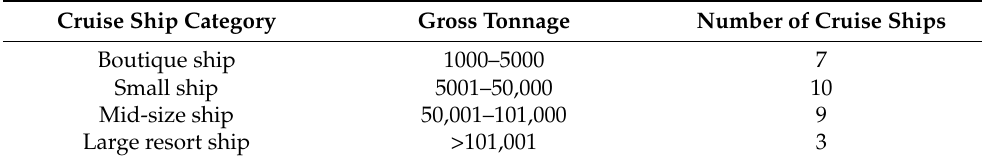
Table 1. Categorization of cruise ships in the Port of Kotor in 2022